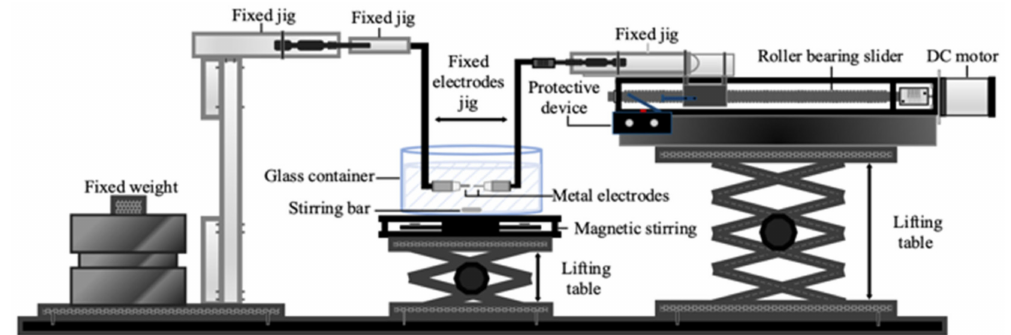
Figure 2. Design of